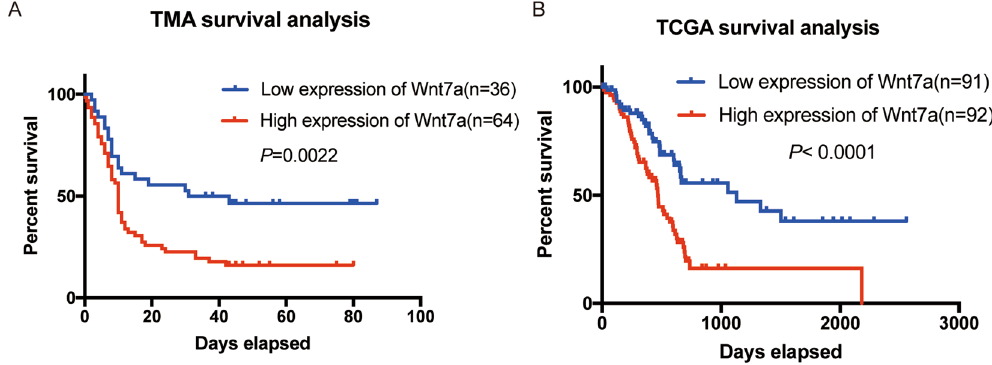
Figure 2. Kaplan-Meier survival analysis of WNT7A expression in PDAC patients. ( A , B ) Kaplan-Meier survival analysis based on the expression of WNT7A in TMA cohort ( A ) and TCGA cohort ( B ).